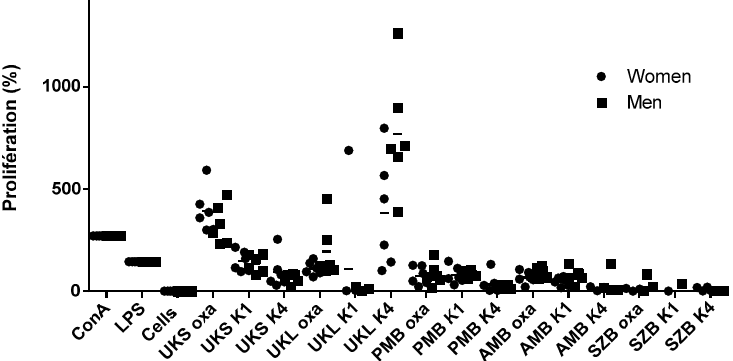
Figure 2. Proliferation of PMBCs from 12 volunteers stimulated by polysaccharide extracts: oxalate (oxa), 1 M KOH (K1) and 4 M (K4) compared with concanavalin A (ConA), lipopolysaccharide (LPS) and unstimulated cells; mean ± SD.